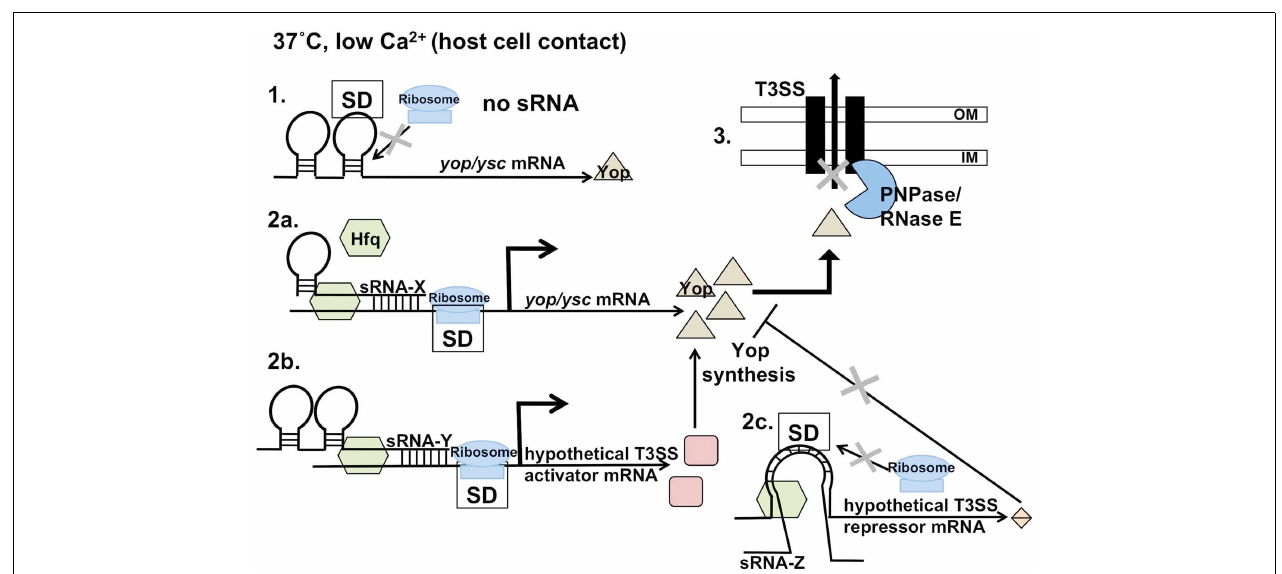
Alternatively, regulation may be indirect through Hfq-dependent stimulation/stabilization of a secondary post-transcriptional activator of the T3SS, or 2c. Hfq-dependent repression/degradation of a post-transcriptional repressor ofT3SS. Both of these scenarios would result in increasedYop production in an sRNA-dependent, post-transcriptional manner. UponYop production, PNPase and RNase E may block secretion/translocation of theYop at a terminal step if conditions are